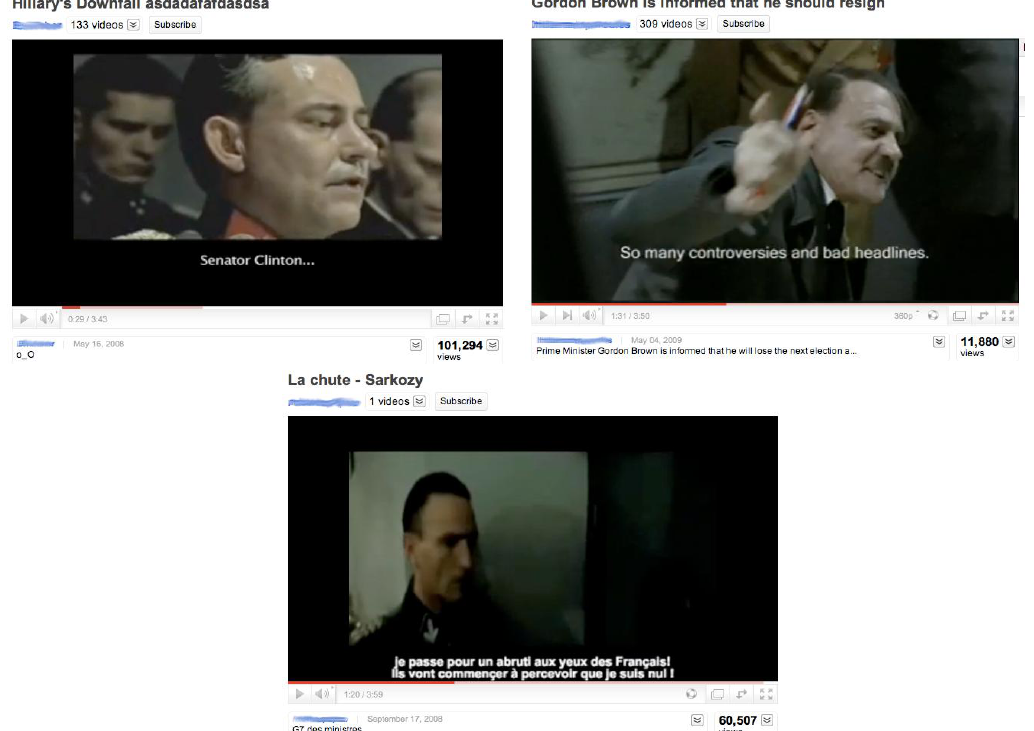
Figure 3: Videos “Hillary's Downfall,” “Gordon Brown is informed that he should resign,” “La chute – Sarkozy” (from left to right, top to bottom). Screenshots taken on September 11,